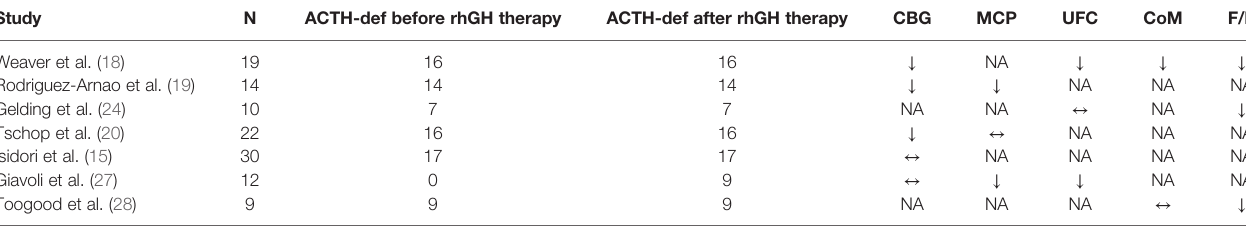
TABLE 1 | Modi fi cations of hypothalamic-pituitary- adrenal axis during GH therapy in AGHD. Study N ACTH-def before rhGH therapy ACTH-def after rhGH therapy